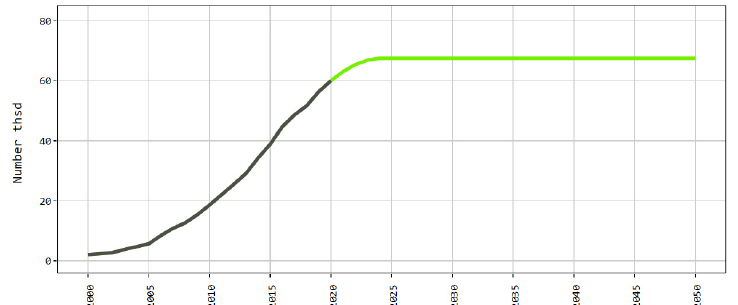
Figure 13. Number of suckler cows in Latvia in 2000–2020, with a projection for 2021–2050, thousands [62].